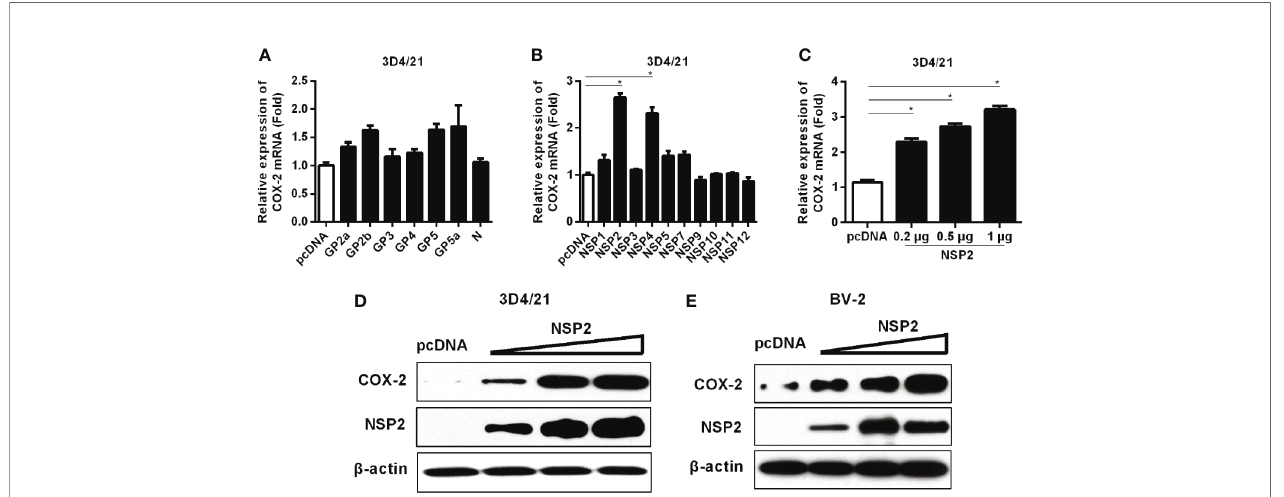
FIGURE 4 | Determining the effect of HP-PRRSV NSP2 on COX-2 activation. (A, B) 3D4/21 cells were transfected with HP-PRRSV structural (A) and nonstructural protein (B) expression vectors. At 24 hours later, cells were harvested for COX-2 mRNA analysis by real-time PCR. (C, D) 3D4/21 cells were transfected with NSP2 expression plasmids at different doses (0.2, 0.5, 1 m g). At 24 hours later, total RNA was extracted from cell lysates. COX-2 mRNA was quanti fi ed by real-time PCR (C) , and cell lysates were harvested for COX-2 protein analysis by Western-blot (D) . (E) BV-2 cells were transfected with NSP2 expression plasmids at different doses (0.2, 0.5, 1 m g). At 24 hours later, COX-2 protein level was analyzed by Western-blot. Data are representative of three independent experiments (mean ± SEM). Statistical analysis was performed by Student ’ s t -test. *, P < 0.05